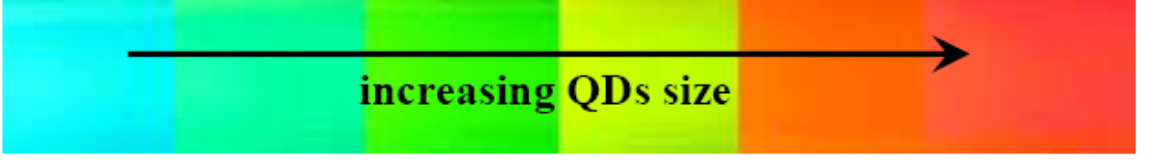
Figure 2. An example of QDs sorted by size emitting light of different colors excited simultaneously by a single excitation